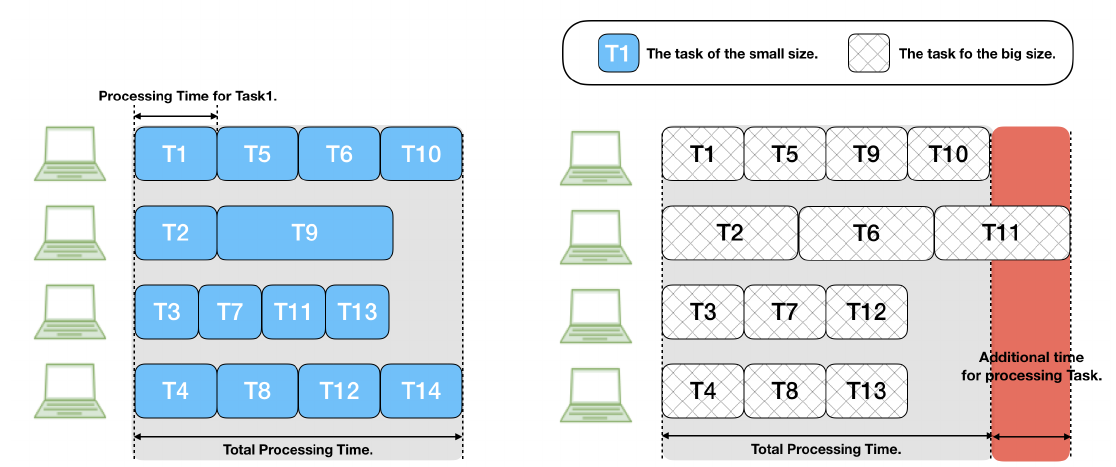
Figure 3. Task processing time in the task distribution model based on task segment